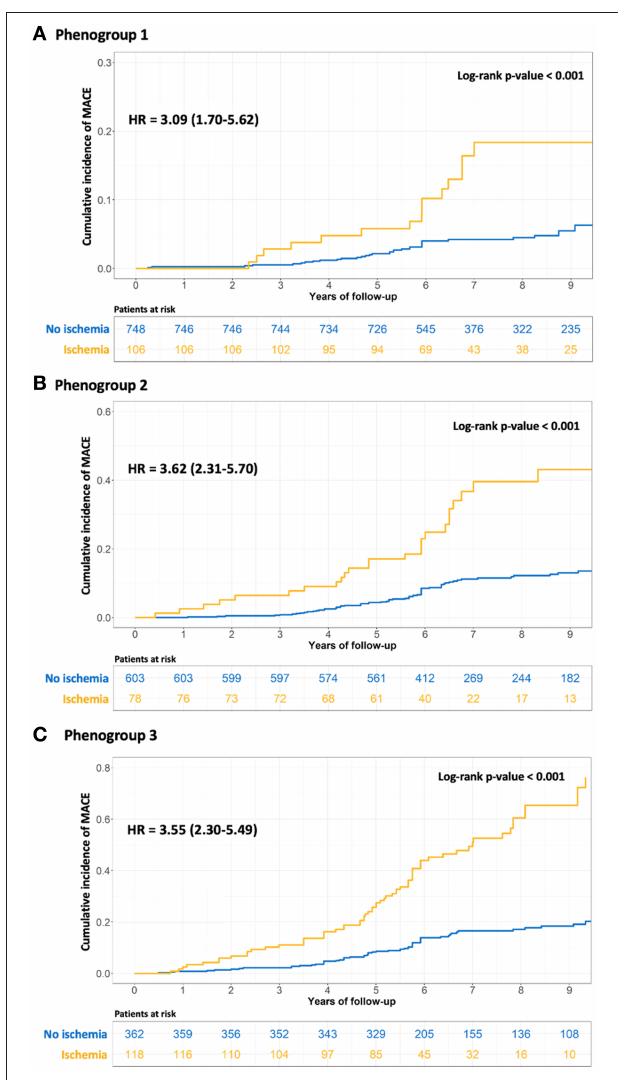
FIGURE 5 | Kaplan-Meier curves for MACE in each phenogroup stratified by inducible ischemia on stress CMR. The univariable analysis for MACE was performed using the log-rank test to compare patients with and without inducible ischemia in phenogroup 1 (A) , phenogroup 2 (B) , and phenogroup 3 (C)